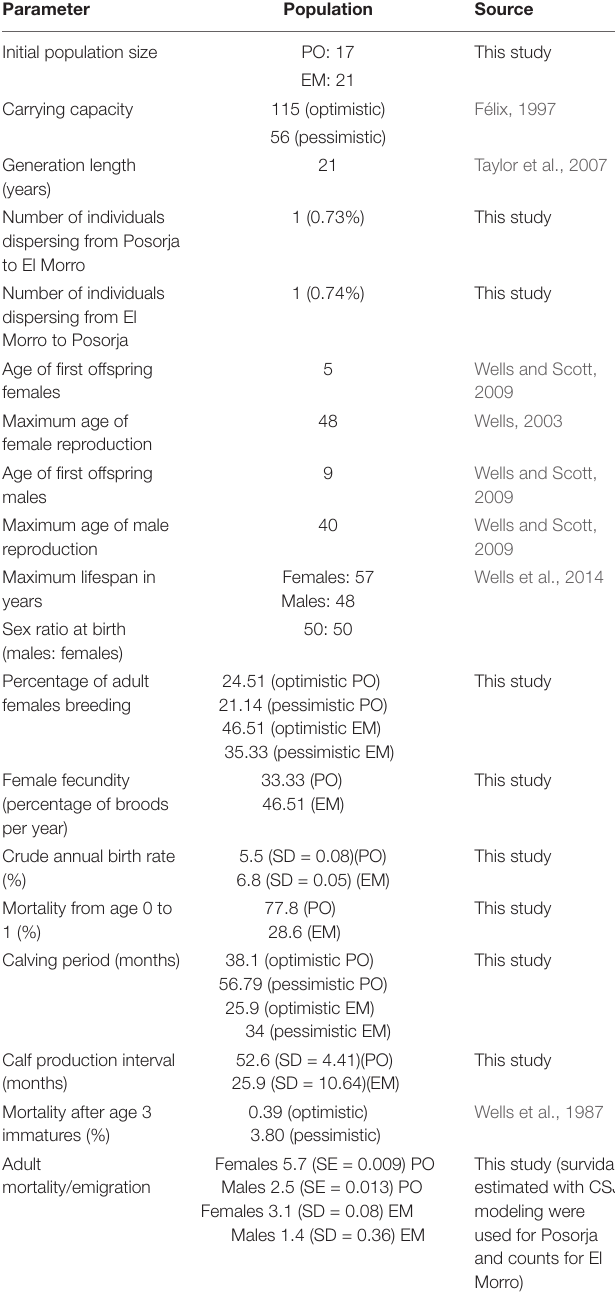
TABLE 4 | Input data for the population viability